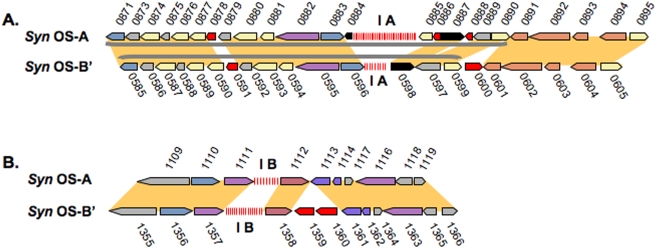
Type I CRISPR regions.A) CRISPR-IA region from Syn OS-A (top) and Syn OS-B′ (bottom). The cas gene cluster is indicated by a grey bracket. B) CRISPR-IB region. Gene identifiers are shown above or below each gene, excluding the GenBank locus tag prefix ‘CYA_’ (for Syn OS-A) or ‘CYB_’ (for Syn OS-B′). Genes are color-coded following the COG-based IMG convention (http://img.jgi.doe.gov), (described in Figure 4), except that genes annotated as “hypothetical protein” are in grey, genes with no putative ortholog in the other genome are in red, and genes annotated as transposases are in black. Orthologous genes are indicated by yellow blocks. Detailed information on each gene is available in Table S3.